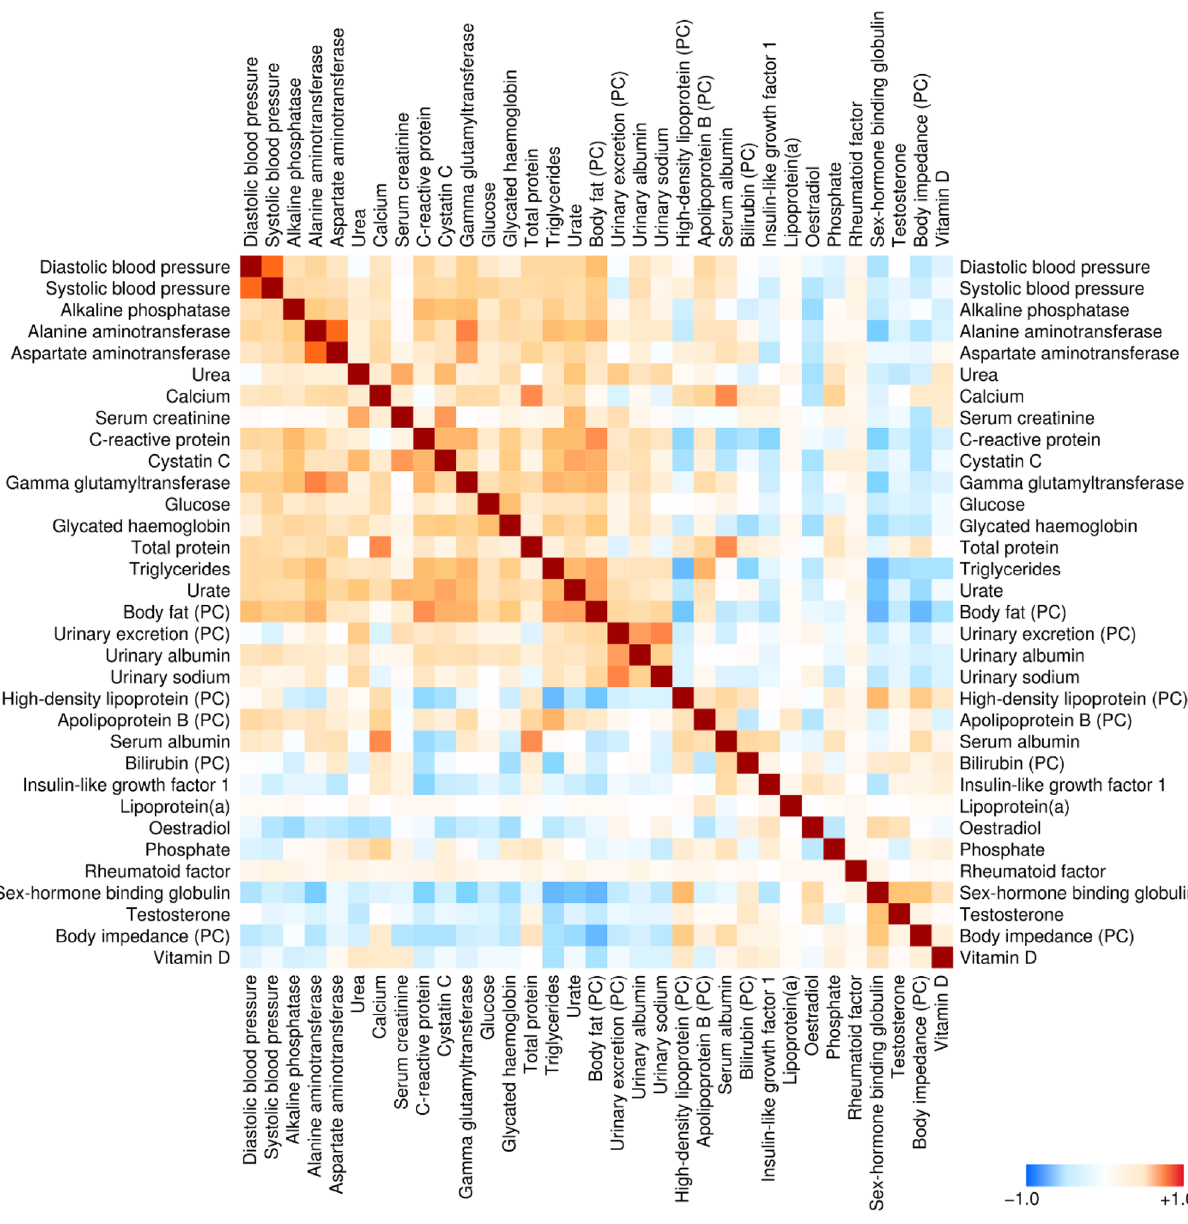
Figure 1. Spearman correlations between anthropometric and biochemical features that comprised the training set for the self-organizing map (adjusted for age and sex). Highly collinear variables were collapsed into the principal component score (PC) prior to correlation